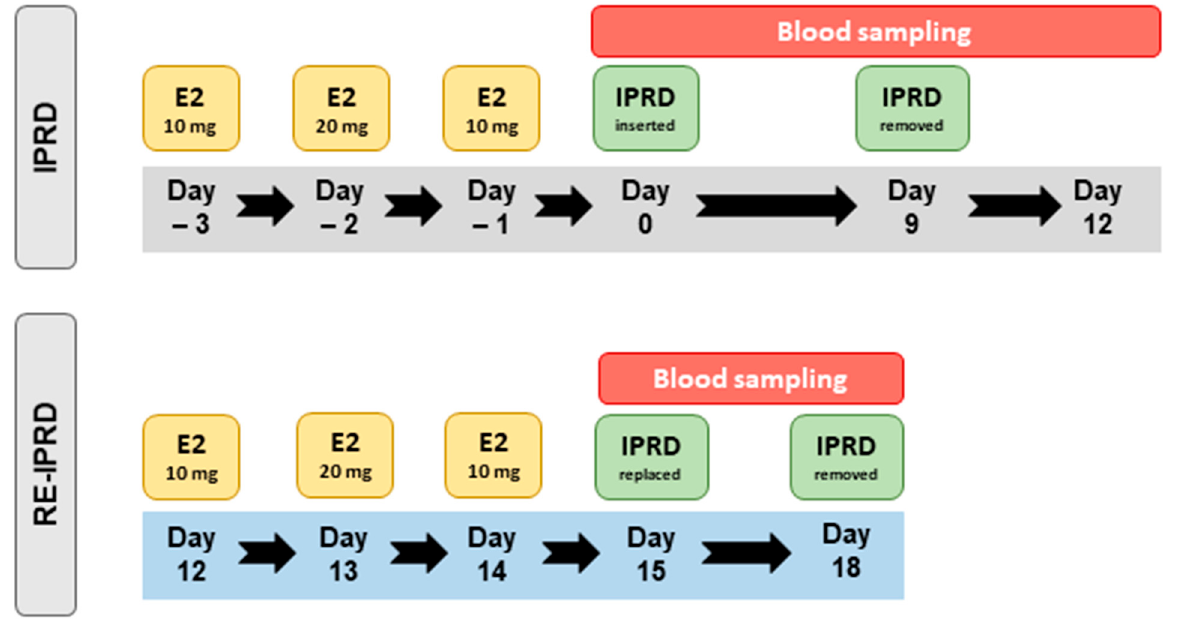
Figure 2. Timeline for blood sampling and hormone treatments administered to mares synchronized (IPRD) and resyn ‐ chronized (RE ‐ IPRD) with an intravaginal progesterone ‐ releasing device (IPRD). Estradiol ‐ 17 β (E2) (17 β eta ® , 10 mg, IM); IPRD (1 g of natural progesterone). D0 is equivalent to the day of ovulation. Initially, acyclic mares were treated with estradiol ‐ 17 β for 3 days and then given an IPRD (D0). The IPRD was kept for nine days and then removed (D9). Mares were resynchronized three days after removal of the IPRD (i.e., D12, after the first synchronization). Estradiol ‐ 17 β was given for three days (D12–D14), and then had a new IPRD inserted (D15) and removed three days later (D18).